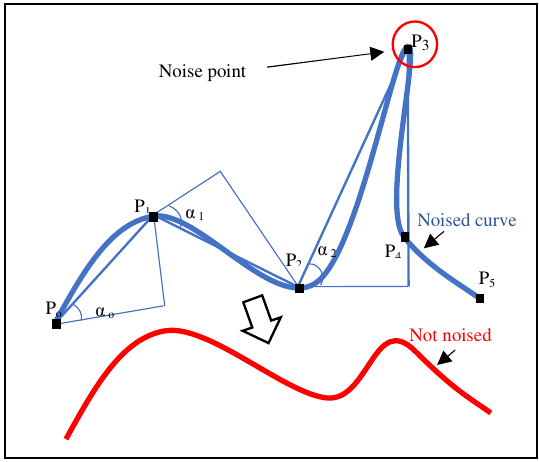
Fig. 1. Demonstrate the Chord Angle Algorithm.